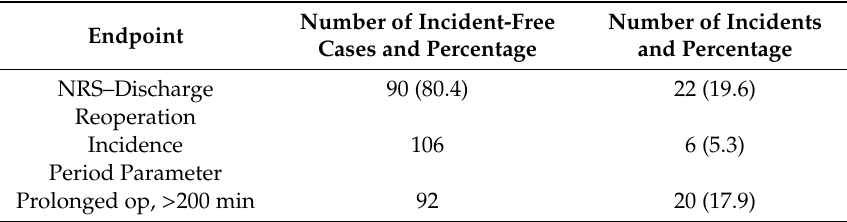
Table 2. Summary of parameter results.